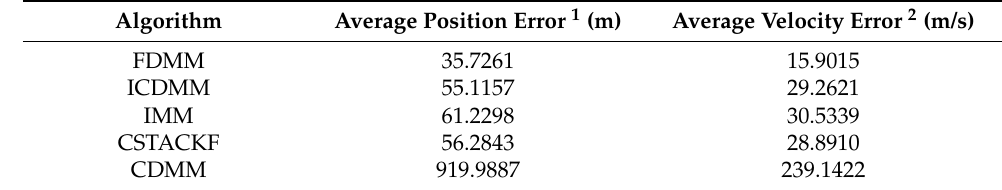
Figure 14. The comparison of the estimated trajectories to the true trajectory in one Monte Carlo run in Case 2. Table 4. The average tracking error of the non-cooperative target in the skip-gliding mode.